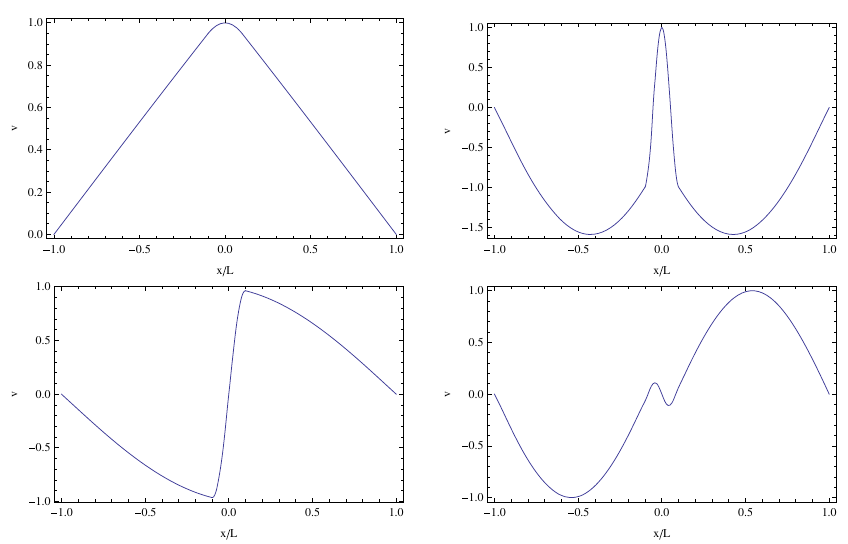
Fig. 34 Spatial distribution of some normal modes of the string shown in Fig. 33c. Top left: hybrid mode. Top right: first internal even overtone. Bottom left: first internal odd overtone. Bottom right: first external odd overtone. The spatial coordinate is given in units of L and the string of density ρ p is in the range − 0 . 1 ≤ x ≤ 0 . 1. The wave speeds are c pro = 15 and c cor = 166 km s − 1 , representative of prominence and coronal sound speeds, and the density ratio is ρ p /ρ c = 11 .